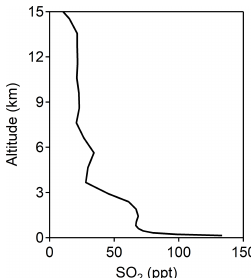
Figure A5. Simulated vertical profile of the SO 2 mixing ratio (STP) at the location of